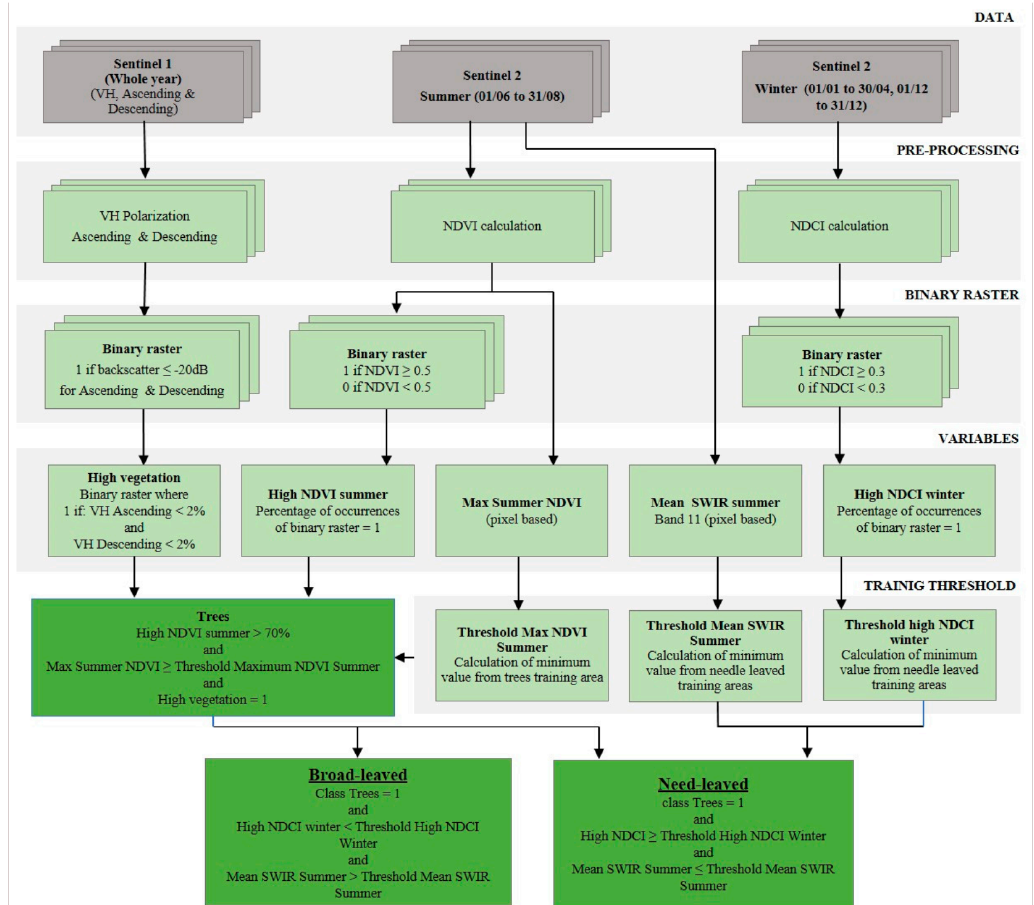
Figure A3. Workflow for woody vegetation classification.